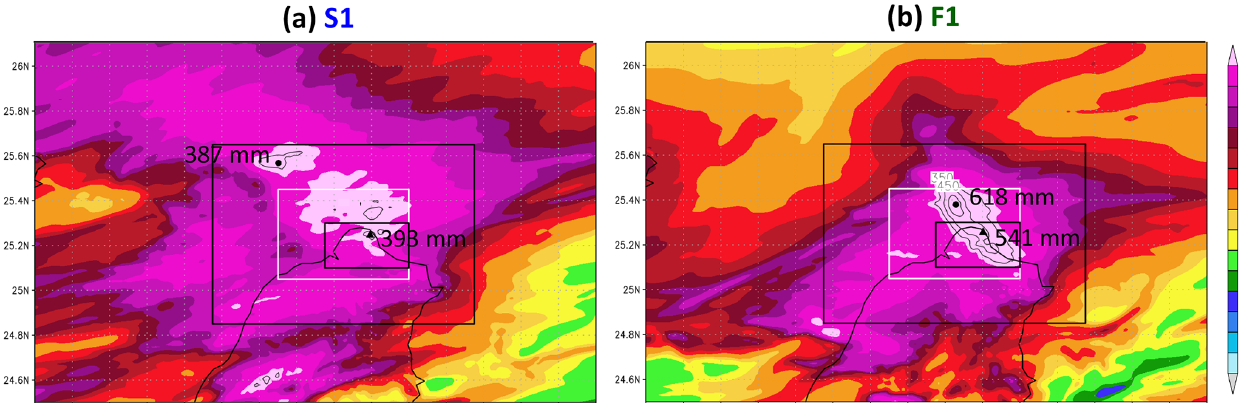
Figure 9. Distribution of 24h accumulated rainfall (mm, color) around northern Taiwan in experiment (a) S1 (from 00:00UTC on 1 June to 00:00UTC on 2 June) and (b) F1 (from 16:00UTC on 1 June to 16:00UTC on 2 June 2017), respectively. Above 300mm, additional contours are drawn at 350, 450, and 550mm. The maximum values overland in northern Taiwan (triangles) and those offshore (dots) are labeled, and the three averaging domains used in Fig. 10 are also